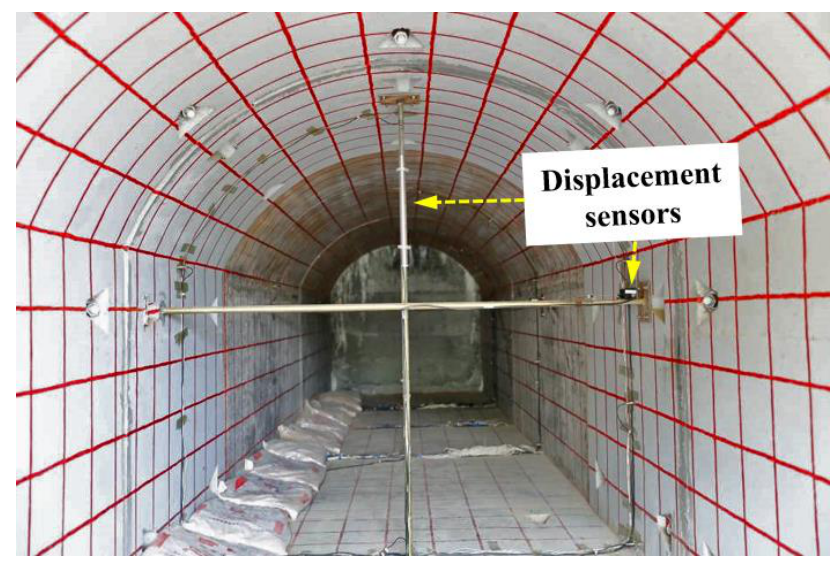
Figure 6. The internal engineering layout of the test sections.